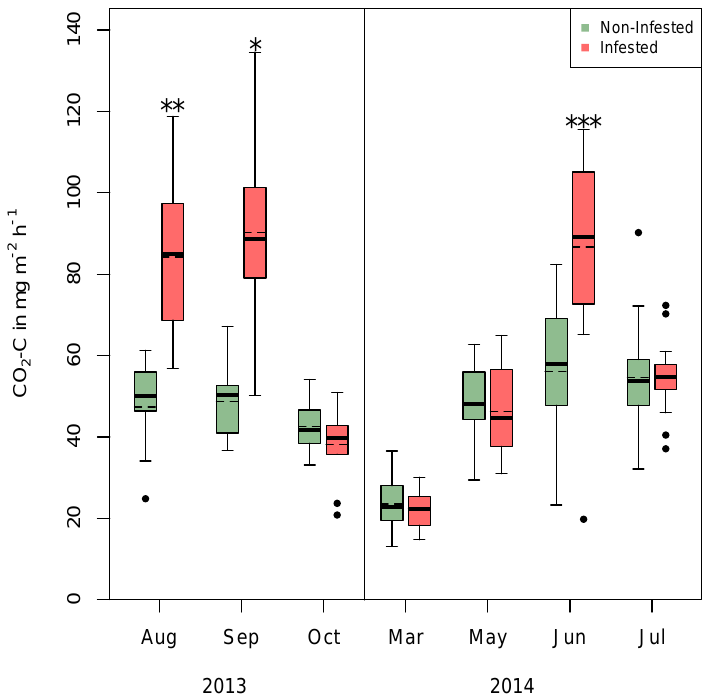
Figure 1. CO 2 -C emissions (mg m − 2 h − 1 ) from the mineral soil during an outbreak of the nun moth ( Lymantria monacha L.) in 2013 and 2014, and the adjacent noninfested control of Scots pine ( Pinus sylvestris L.) forest sites. Infested = red, noninfested = green, Aug = August, Sep = September, Oct = October, Mar = March, Jun = June, Jul = July. Box plots show means (dotted lines) and medians (solid lines) ( n = 9 in 2013 and 15 in 2014 for each plot). Whisker extension equals 1.5 times interquartile range distance. Asterisks indicate significant differences between infested and control plots within one sampling time (paired Wilcoxon signed-rank tests, p ≤ 0.050).